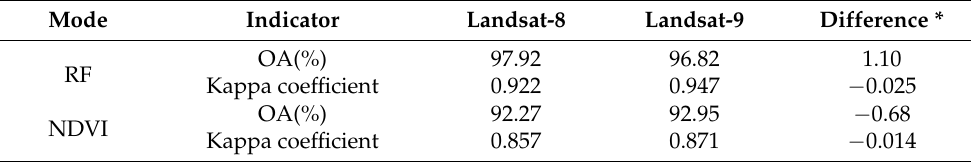
Table 5. Comparison of the overall accuracy of water extraction.